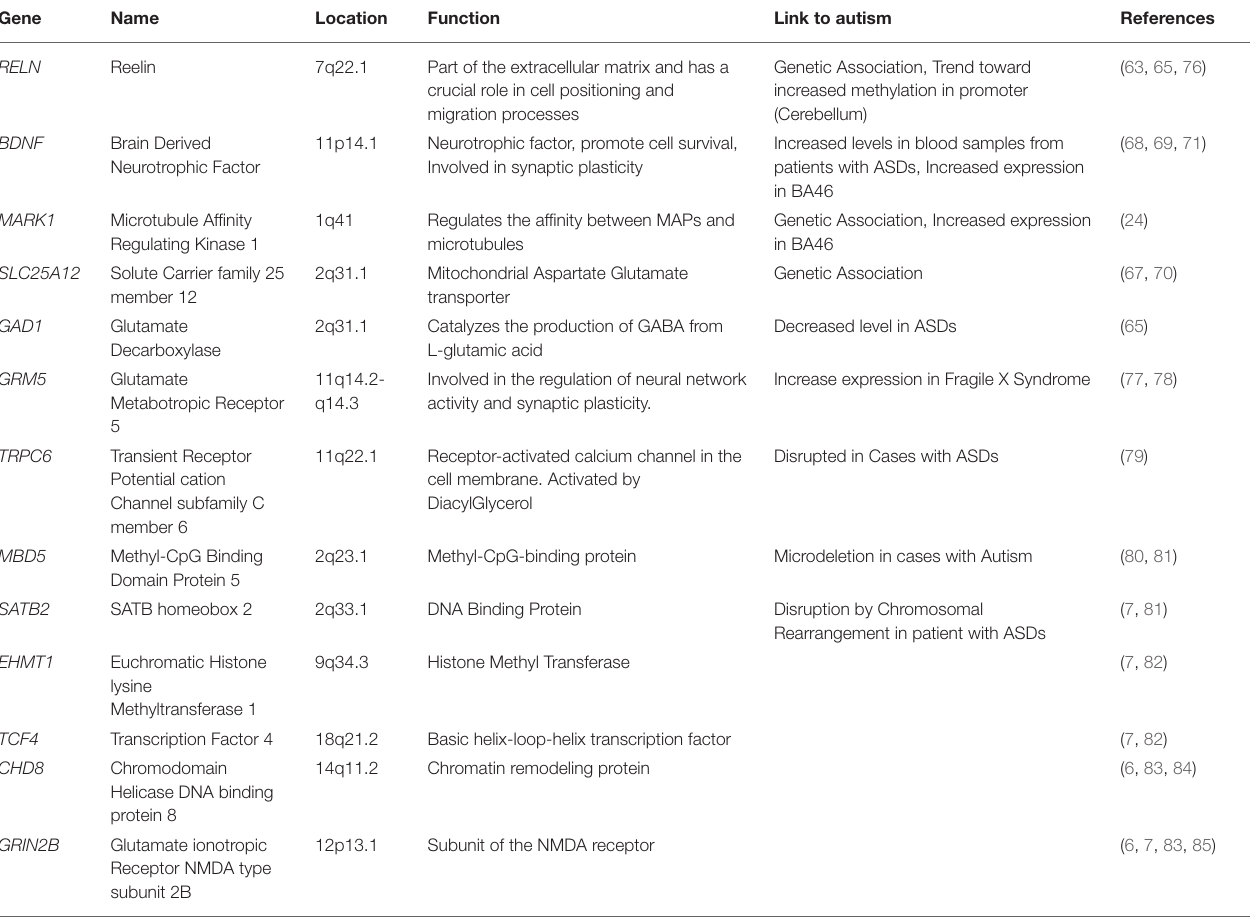
TABLE 2 | Candidate genes of ASDs whose expression has either been assessed on post-mortem brain tissue and or in iPSC-derived